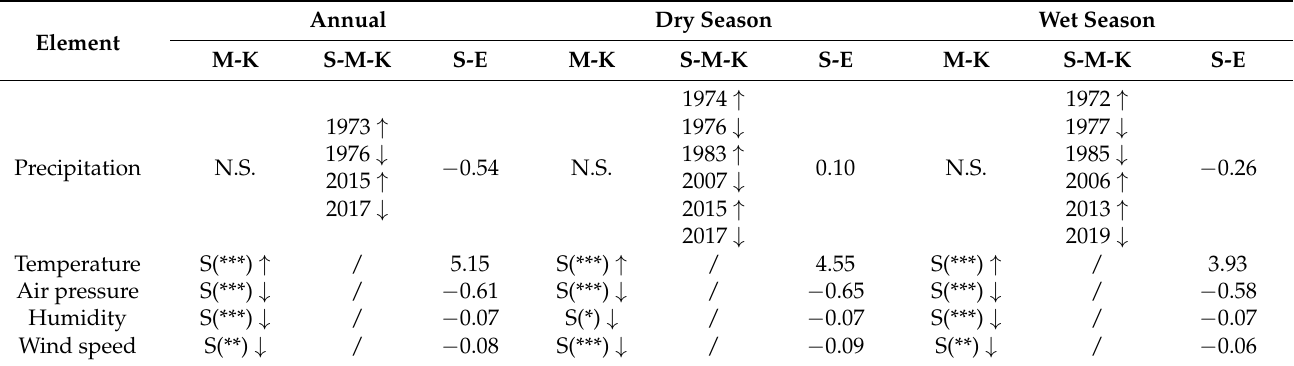
Figure 6. Spatial distribution pattern of variation trend of evapotranspiration in subbasins from 1970 to 2020. Note a: S indicates significant M-K test; N.S. indicates not significant. ↑ Indicates an increase; ↓ indicates a decrease. Note b: *** indicates significant at the α = 0.001 level, ** indicates significant at the α = 0.01 level, * indicates significant at the α = 0.05 level, + indicates significant at the α = 0.1 level. Table 5. M-K, S-M-K, and S-E test results of climatic factors from 1970 to